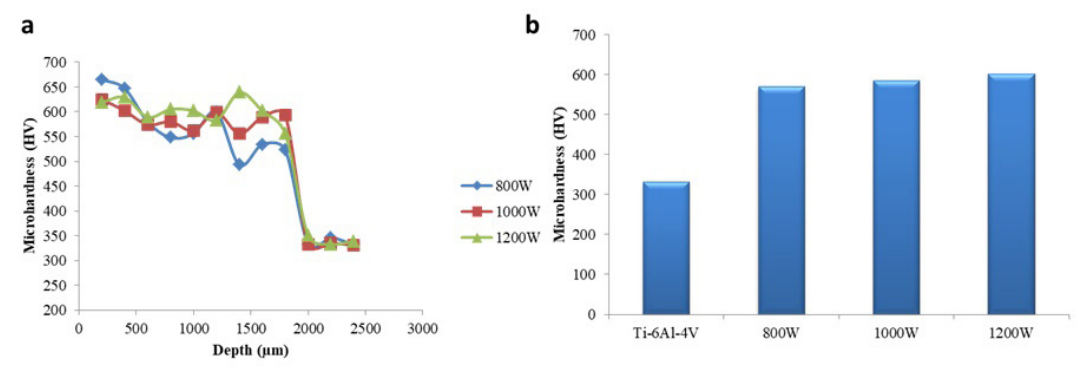
Figure 6. Microhardness of values of Ti10Fe5Si5Cr3Nb composite coatings (a) profile and (b)